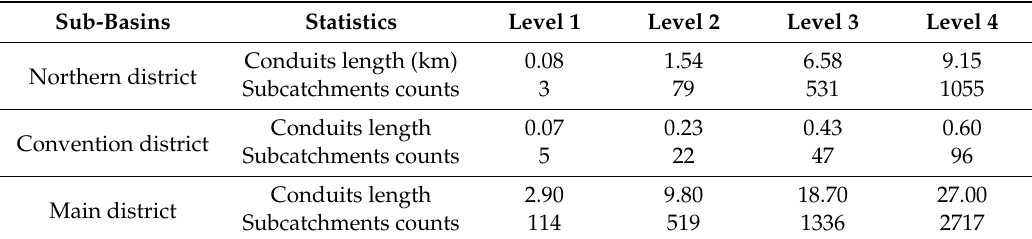
Table 3. Conduit length and subcatchment counts for different drainage system complexities of the three